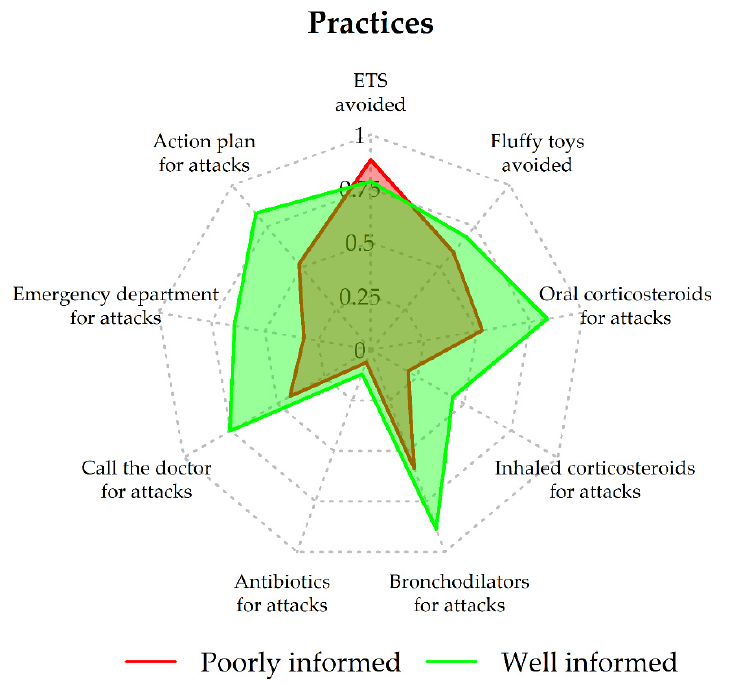
Figure 2. Practices: probabilities of positive response by class. ETS: environmental tobacco smoke. Using posterior probabilities, 145 mothers (33%) were assigned to Class 1, while 293 mothers (67%) were assigned to Class 2, consistently with the estimated prior probabilities of class membership (0.33 and 0.67, respectively).